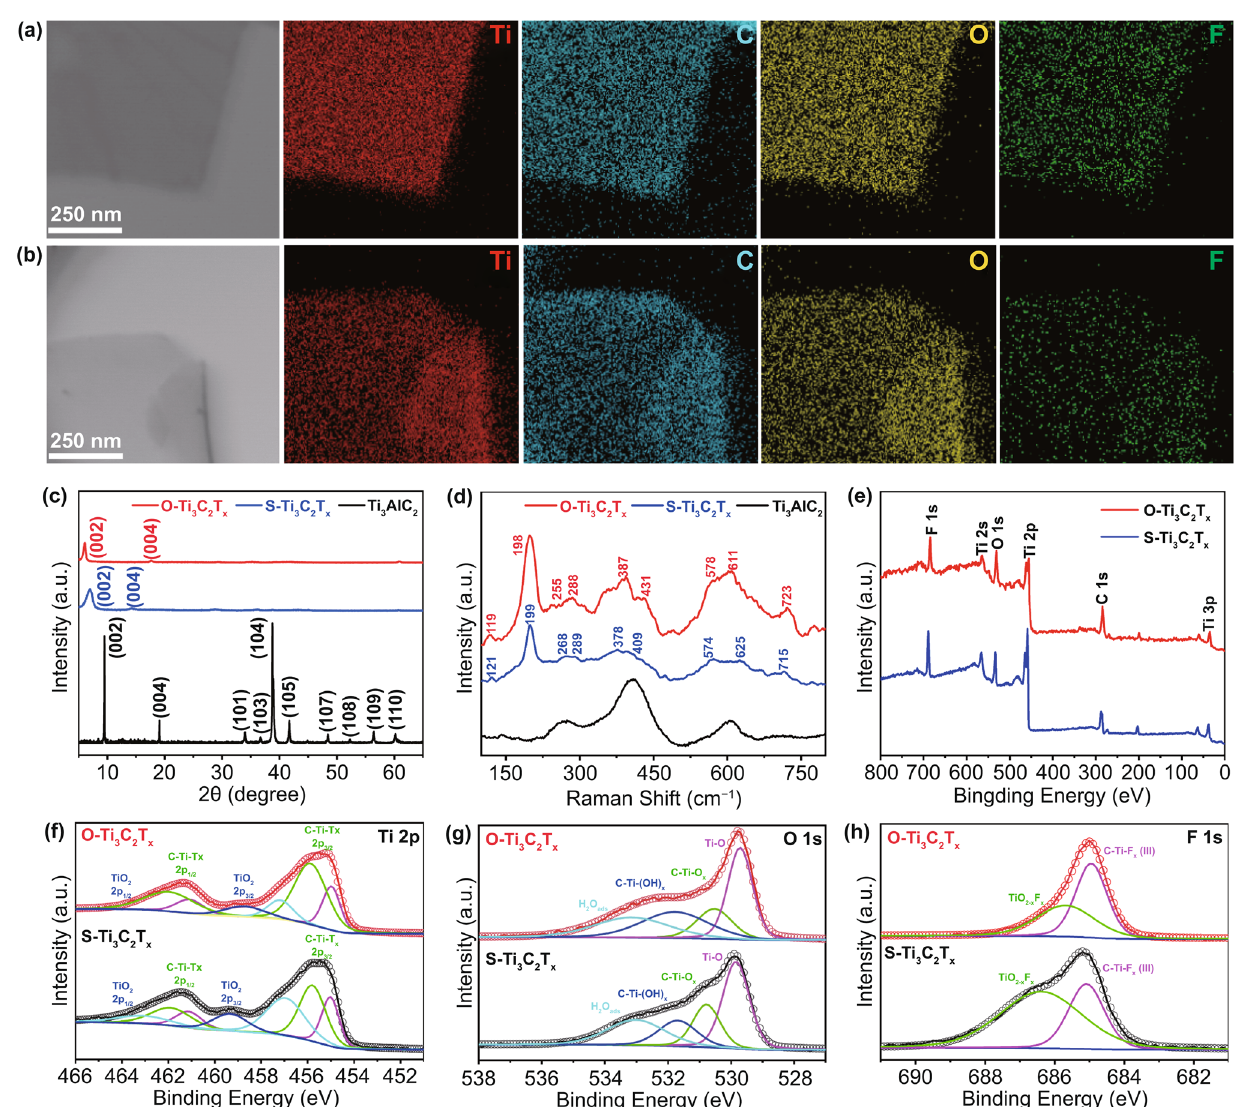
Fig. 4 TEM images of a S-Ti 3 C 2 T x and b O-Ti 3 C 2 T x flakes and their corresponding elemental maps of Ti, C, O and F elements. c XRD patterns and d Raman spectra of Ti 3 AlC 2 , S-Ti 3 C 2 T x and O-Ti 3 C 2 T x . e XPS survey spectra and high-resolution spectra with curve-fitting of S-Ti 3 C 2 T x and O-Ti 3 C 2 T x for f Ti 2p region, g O 1 s region and h F 1 s